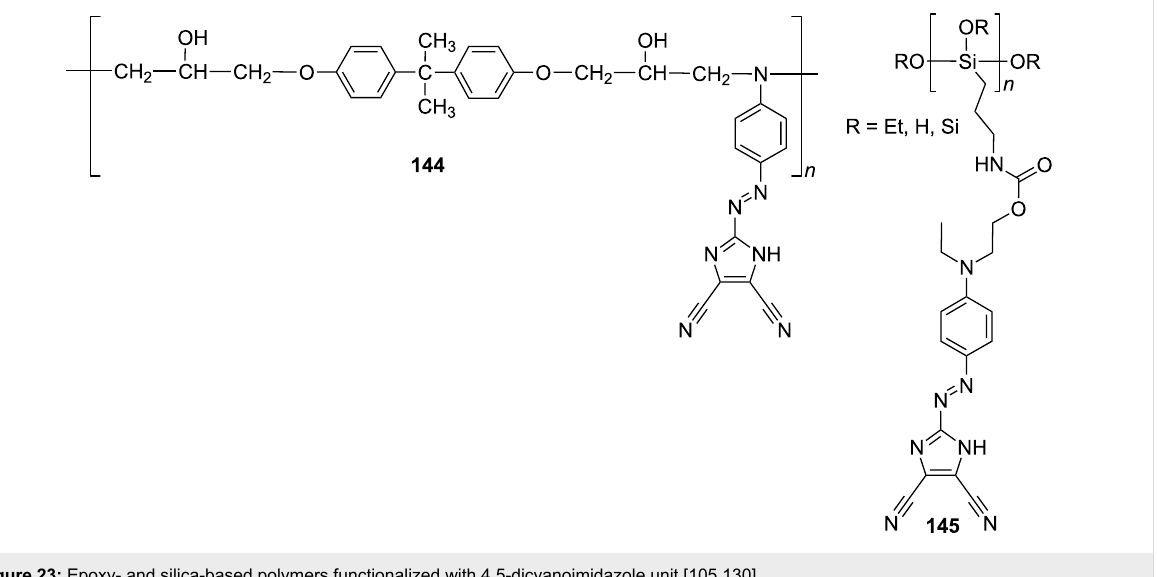
terials exhibited their longest absorption maxima λ max at 490–515 and third-order NLO susceptibility χ (3) (3 ω ; ω , ω , ω ) within the range of 1.5 to 2.6 × 10 − 13 esu (measured by THG at 1064